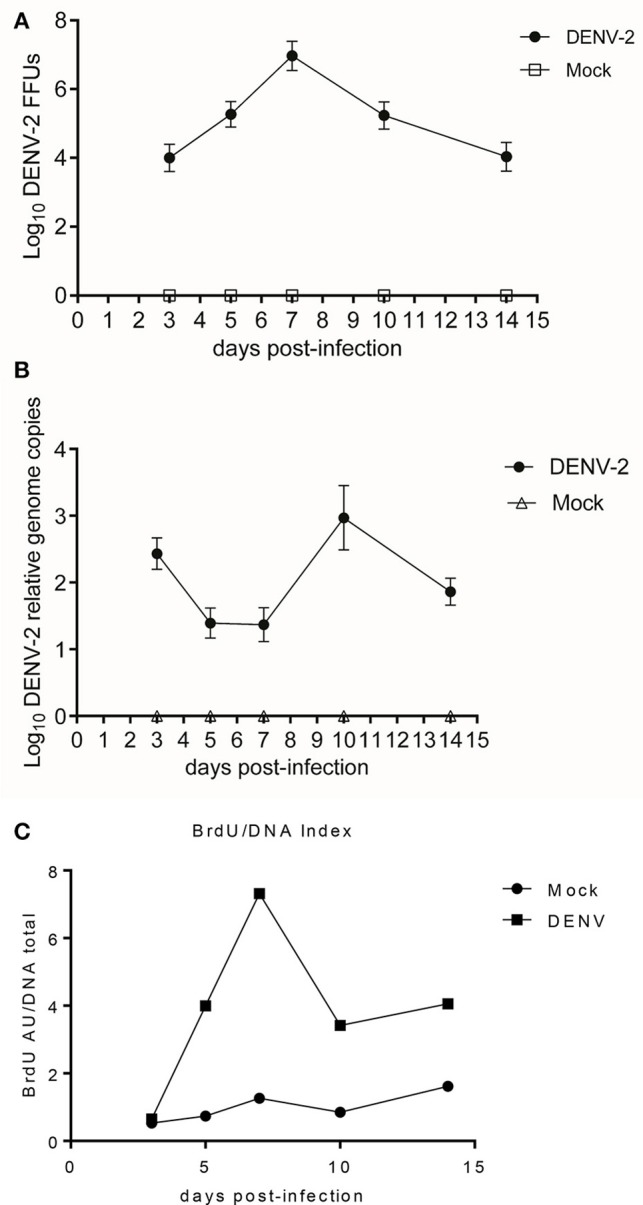
(A) DENV-2 and mock-infected midguts kinetics at 3, 5, 7, 10, and 14 days post-infectious blood meal. Focus forming units assay. One-way ANOVA F = 886.0, p < 0.0001. DENV-2 vs. Mock Student's T-test with two-tailed Welch's correction: Midguts FFU of one mosquito 3, 5, 7, 10, and 14 dpi. All comparisons had statistically significant difference t = 30.47, 43.0, 49.25, 39.56, 29.13; p < 0.0001. (B) DENV-2 and mock-infected midguts kinetics at 3, 5, 7, 10, and 14 days post-infectious blood meal. Viral genome copies from DENV-2 and mock-infected midguts lysate. One-way ANOVA F = 299.5, p < 0.0001. DENV-2 vs. Mock Student's T-test with Welch's correction two-tailed: 3, 5, 7, 10, and 14 dpi all comparisons with significant difference t = 30.91, 18.49, 16.27, 18.49, and 27.71; p < 0.0001. (C) DENV-2 and mock-infected midguts kinetics at 3, 5, 7, 10, and 14 days post-infectious blood meal. Kinetic of the Relative BrdU absorbtion/DNA quantity index. We determined the ratio between BrdU signal and total DNA amount, for the DENV-2 and mock-infected midguts over 14 days post infectious/mock blood meal. ELISA for BrdU incorporation. Kruskal-Wallis test = 72.83, p < 0.0001, DENV-2 vs. Mock Mann Whitney Test two-tailed: 3 dpi no statistically significant differences = 0.22, p = 0.1144; 5, 7, 10, and 14 dpi comparisons with statistically significant differences = 6.83, 10.16, 6.36, 5.19; p = 0.0002.